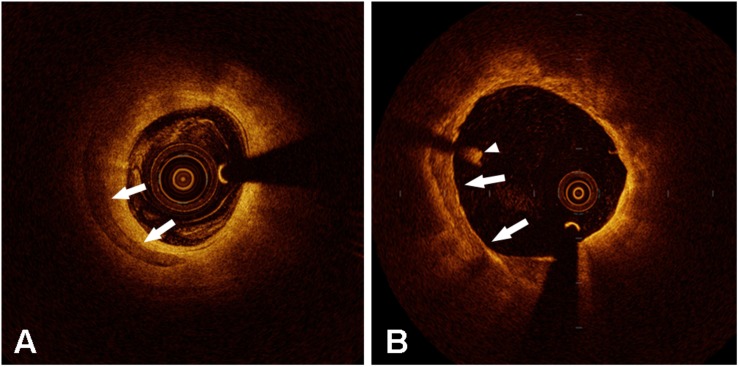
Representative optical coherence tomography images of calcification (arrow in panels A and B). The arrowhead shows an intraluminal white thrombus.